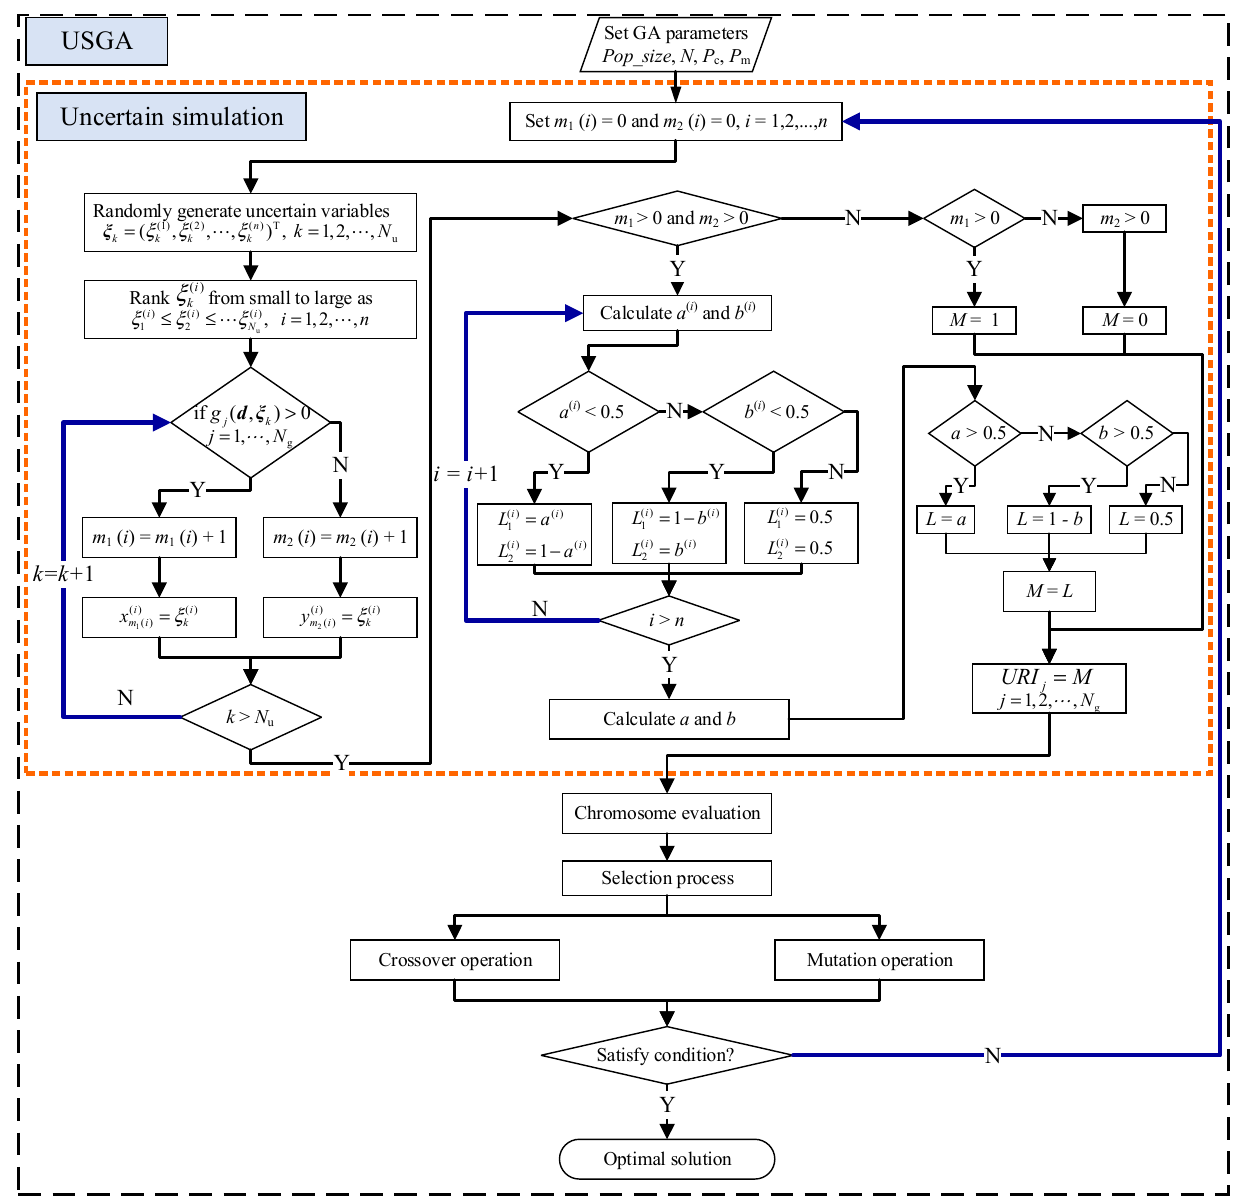
Figure 1. Flowchart of the proposed hybrid intelligent